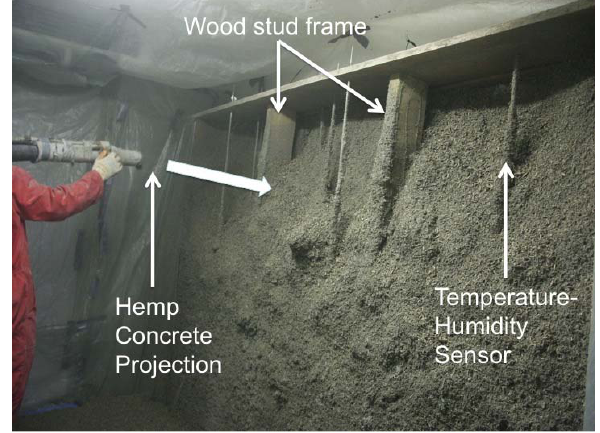
Figure 2. Wall projection and visualization of the wood-stud frame and the